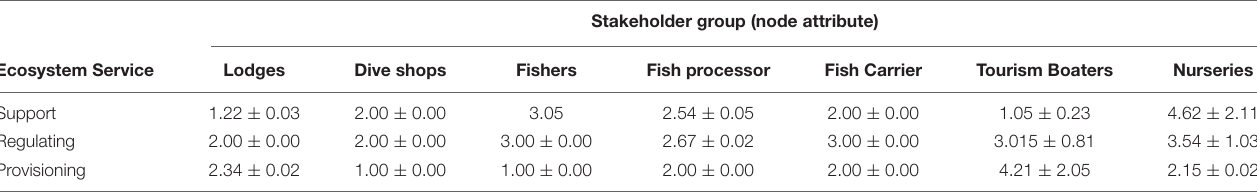
TABLE 4 | Average path length ( ± standard deviation) between each ecosystem service and stakeholder’s group within Los Roques National Park’s socio-ecological network (SEN).